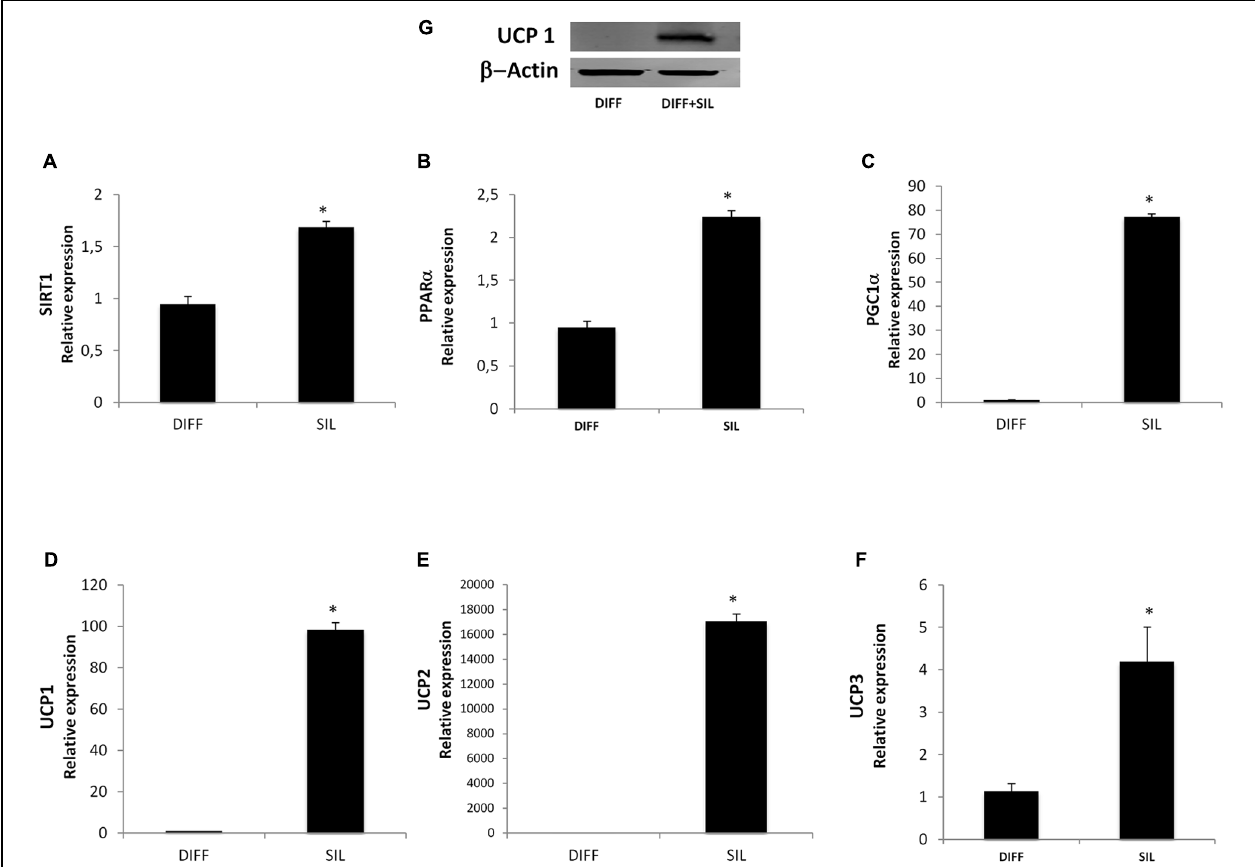
FIGURE 6 | (A–F) Analysis of gene expression, evaluated by Real Time PCR, of cells treated with silibinin for 24 h after adipogenic differentiation. (G) Western Blot analysis of UCP-1 expression in differentiated adipocytes following silibinin treatment. All values are expressed as mean ± SEM of four experiments ( n = 4) in duplicate. ∗ P < 0.05 vs.